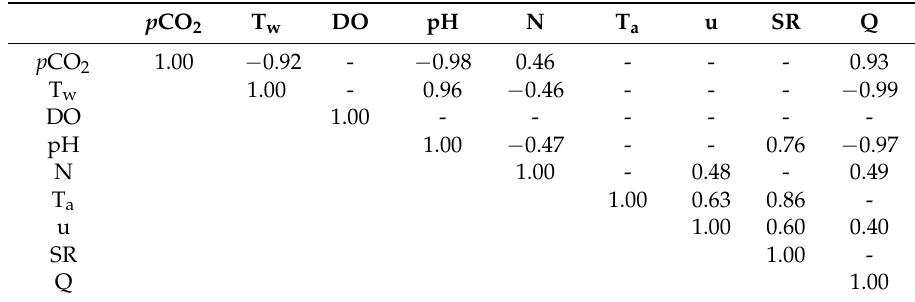
Table 2. Pearson correlation coefficients among p CO 2 , water temperature (T w ), dissolved oxygen (DO), pH, turbidity (N), atmospheric temperature (T a ), wind speed (u), solar radiation (SR), and river discharge (Q). Only significant correlations at α = 0.05 are shown. p CO 2 T w DO pH N T a u SR Q p CO 2 1.00 − 0.92 - − 0.98 0.46 - - - 0.93 T w 1.00 - 0.96 − 0.46 - - - − 0.99 DO 1.00 - - - - - - pH 1.00 − 0.47 - - 0.76 − 0.97 N 1.00 - 0.48 - 0.49 T a 1.00 0.63 0.86 - u 1.00 0.60 0.40 SR 1.00 - Q